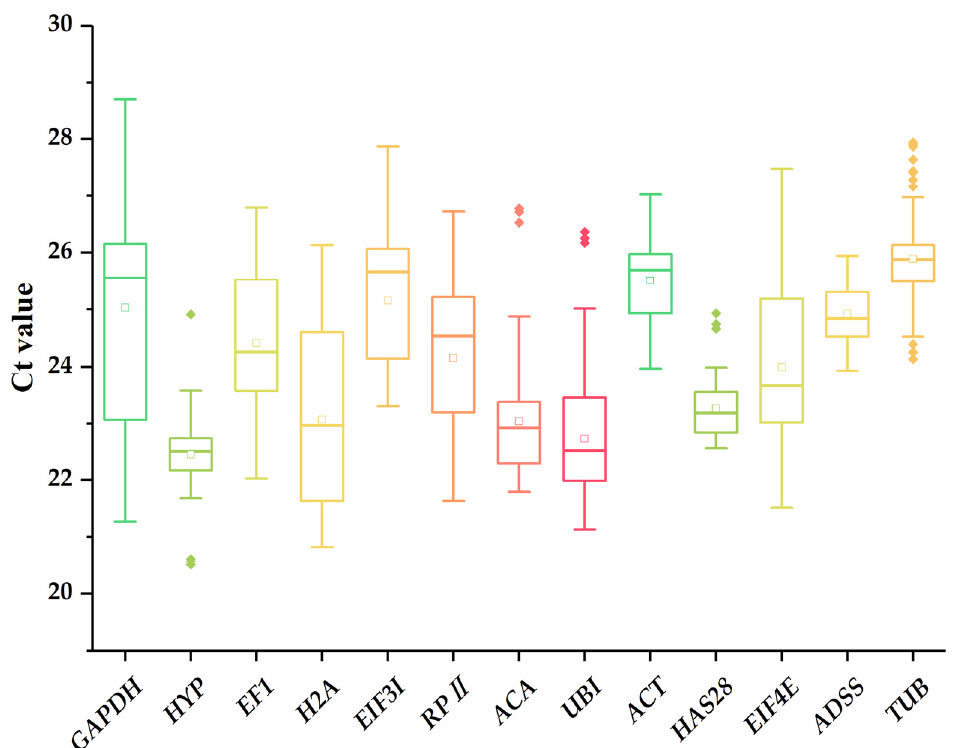
Figure 1. cycle threshold (Ct) values of thirteen candidate reference genes in G. biloba samples. The whiskers, boxes, lines, boxes, and hollow and solid dots represent maximums/minimums, 25th/75th percentiles, medians, means, Ct values, and potential outliers. The different color lines have no practical meaning.